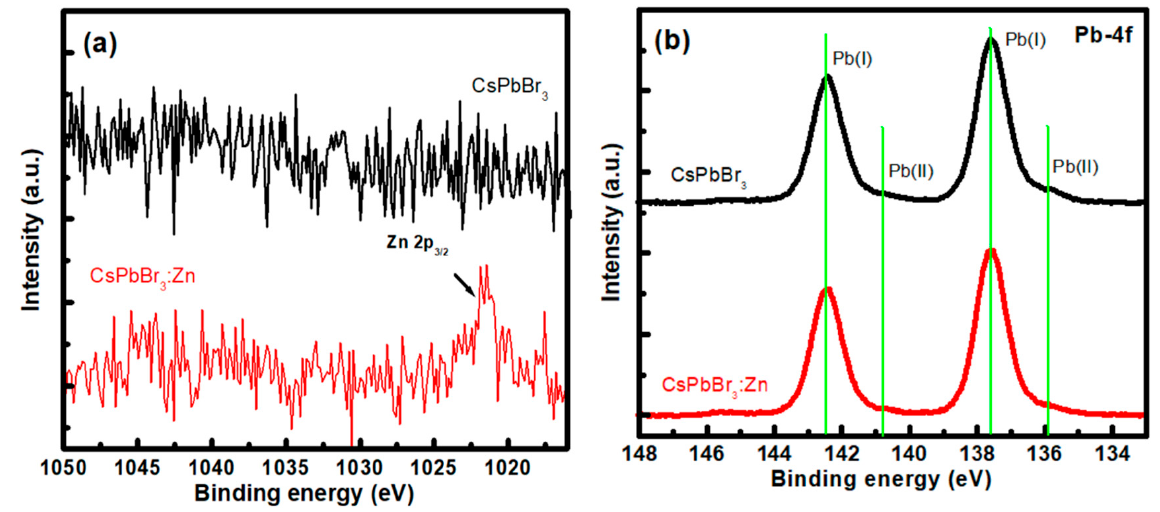
Figure 3. ( a ) Zn-2p and ( b ) Pb-4f core level XPS spectra of CsPbBr 3 and CsPbBr 3 :Zn NCs deposited on Al-coated Si substrates.